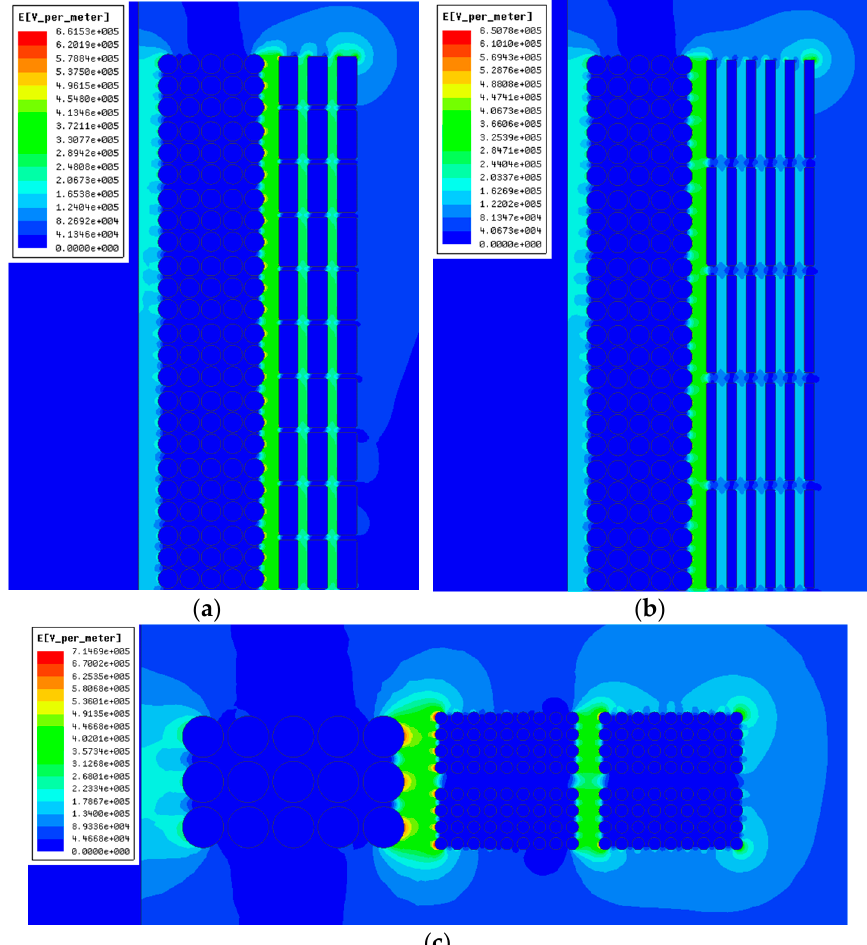
Figure 5. Electric field distribution for different windings: ( a ) N-1; ( b ) N-2; ( c ) N-3.